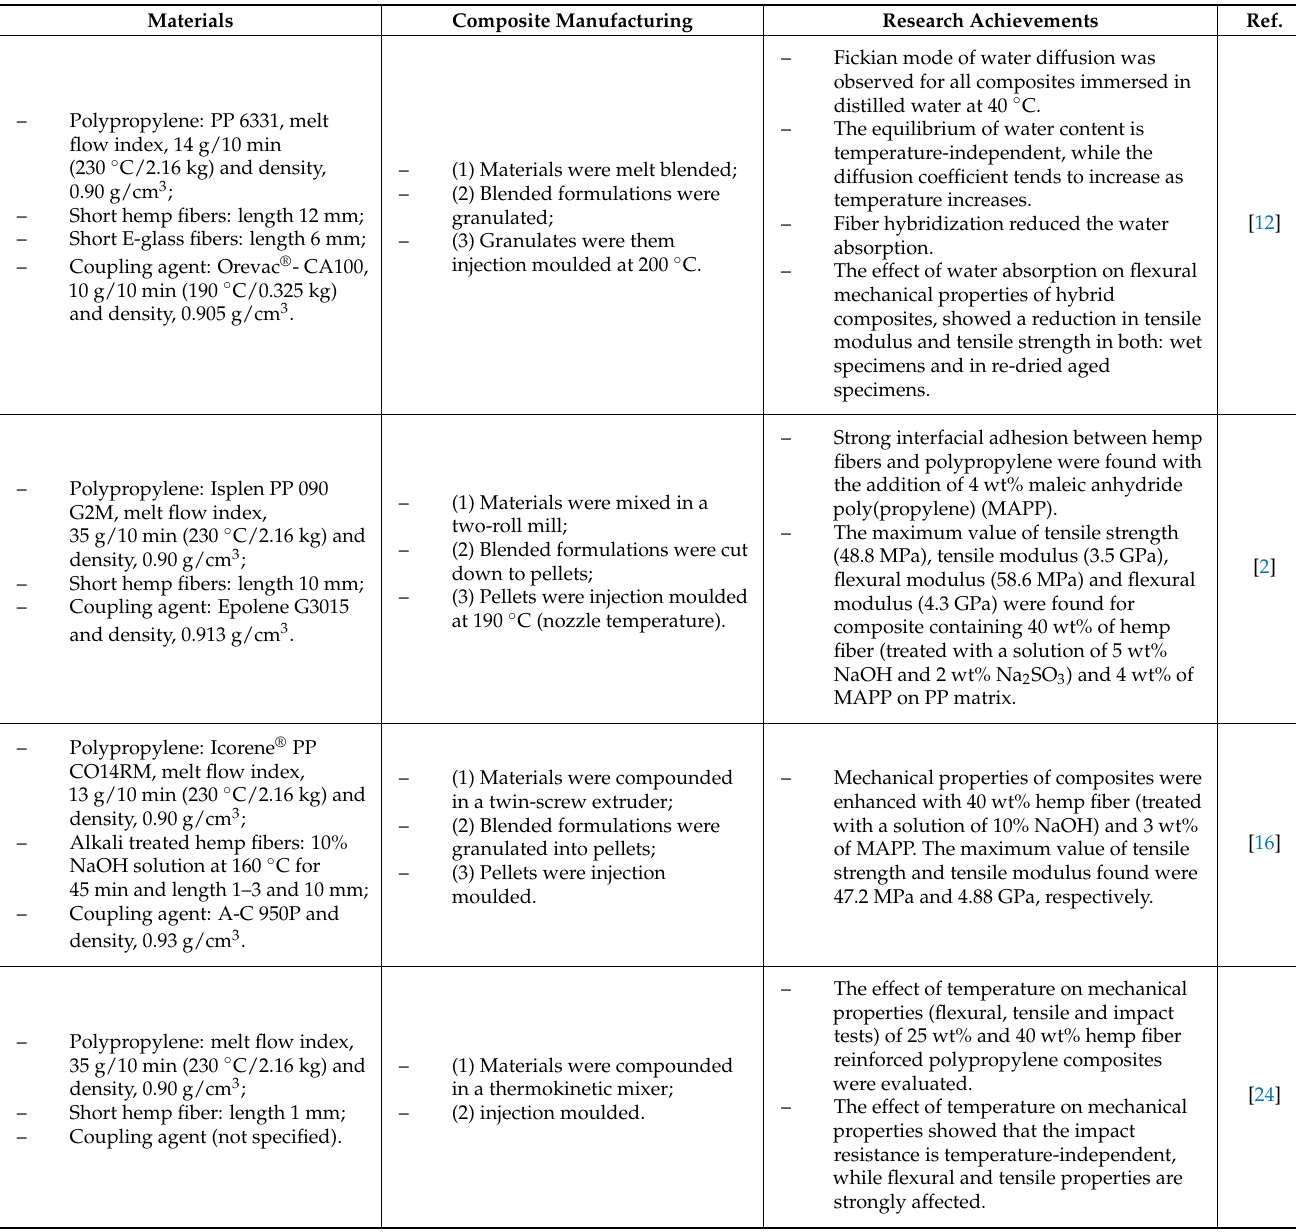
Table 1. Literature review on hemp fiber reinforced polypropylene composites, based on injection mould production. Materials